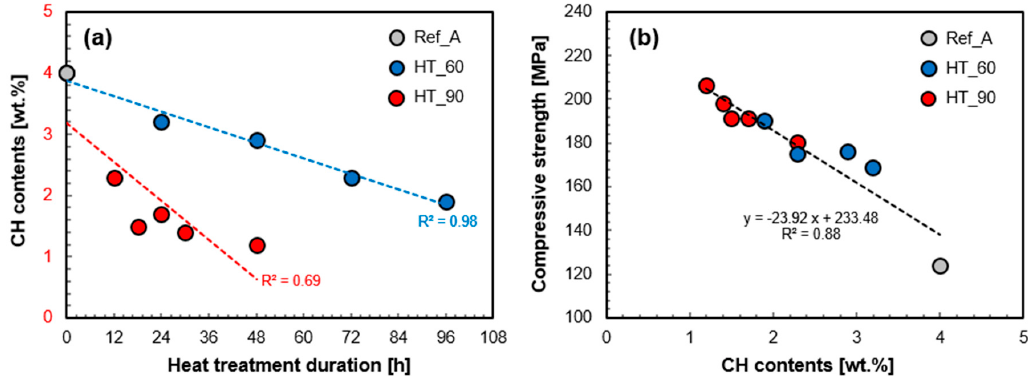
Figure 9. Portlandite content (at 7 days) as a function of HT temperature and duration ( a ); and found relationship between portlandite content and compressive strength at 7 days ( b ).